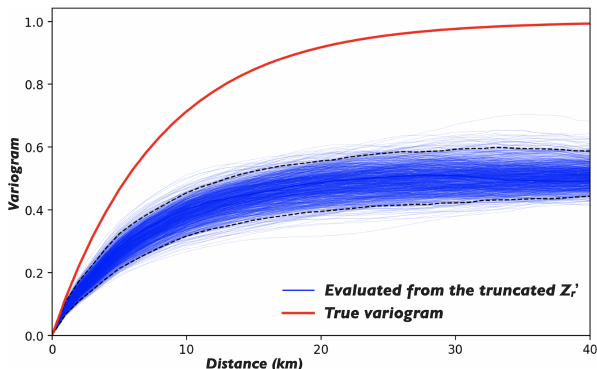
Figure 2. The blue lines denote the empirical variograms evaluated from 1000 truncated Gaussian fields; the 95% confidence interval is marked by the black dashed lines. The red line denotes the true variogram used to generate the continuous Gaussian fields. Note that the continuous Gaussian field is truncated at z 0 = (cid:56) − 1 ( 0 . 36 )